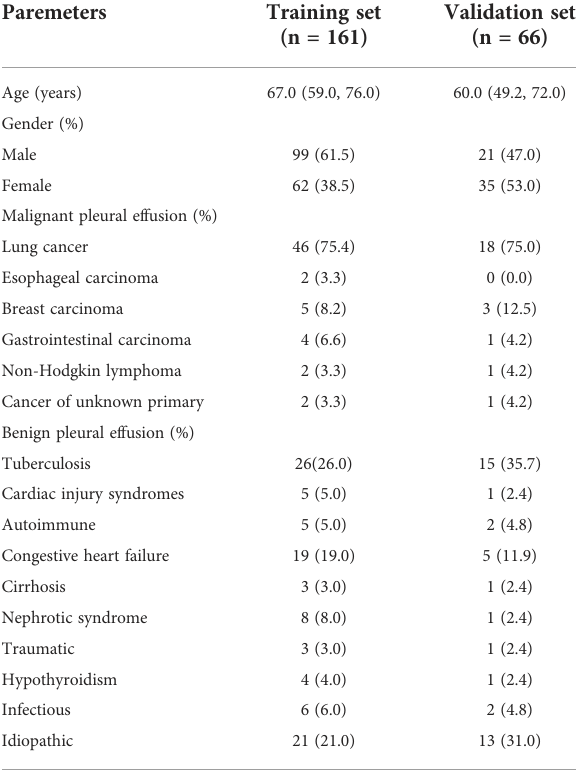
TABLE 1 Baseline characteristics of the study